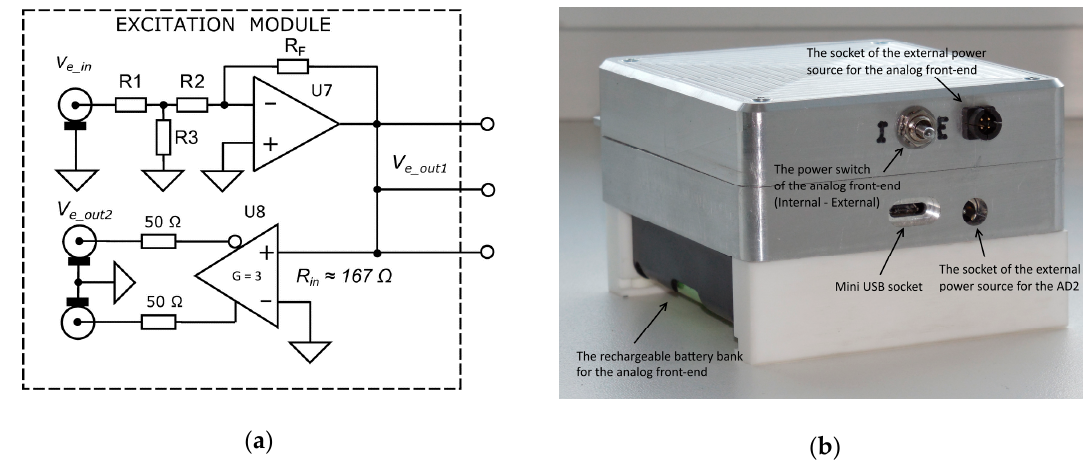
Figure 6. Structure of the front-end electronics of the excitation module ( a ) and backside of the analyzer with dual polarity 3 Ah rechargeable battery bank at the bottom ( b ).